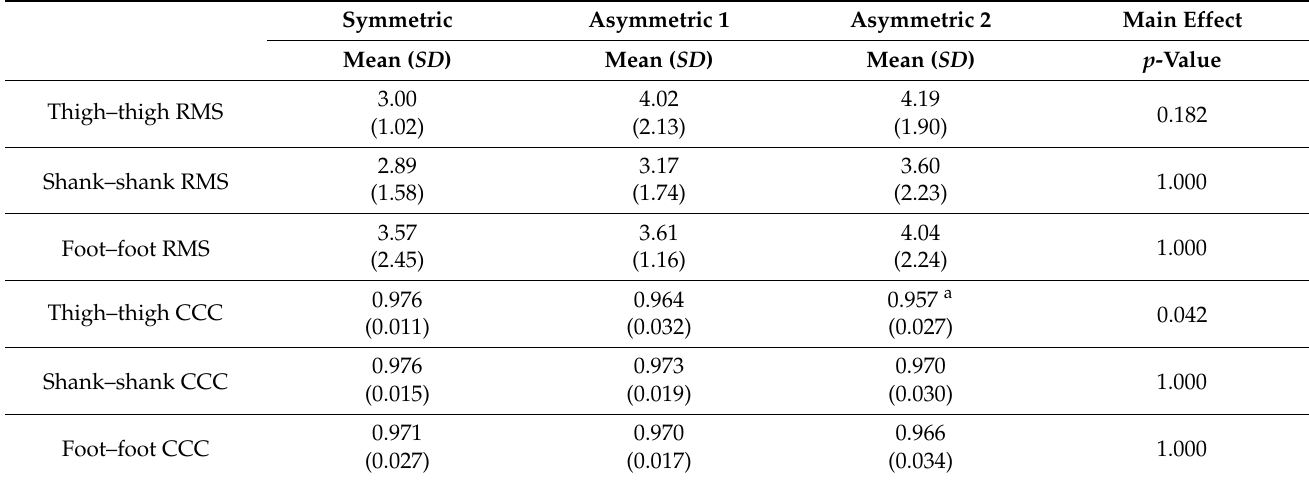
Table 2. Root mean square (RMS) difference and cross-correlation coefficient (CCC) for thigh-thigh, shank-shank, foot-foot couplings (interlimb coordination) over a gait cycle. a p < 0.05 vs. symmetric